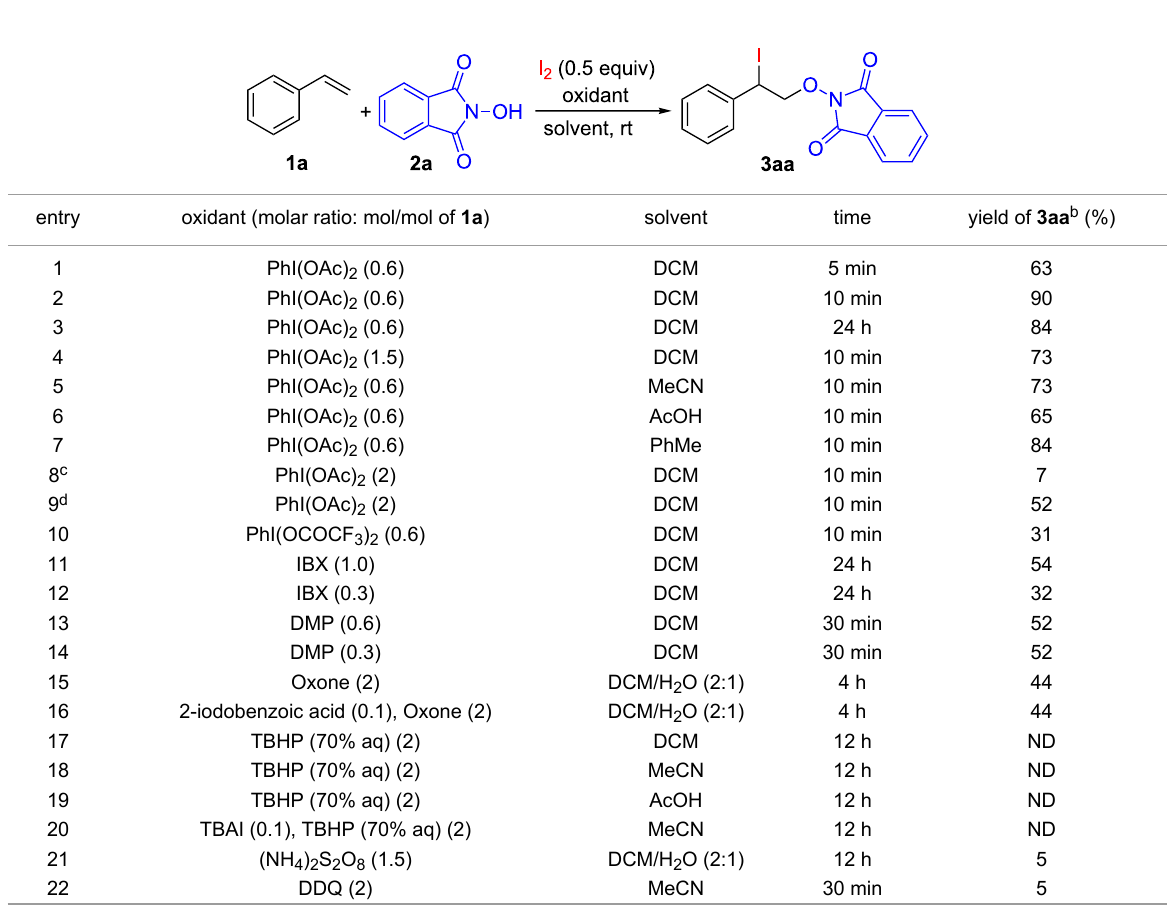
(Figure 2). Details of the data collection and refinement are pro- vided in Supporting Information File 1 and can be obtained